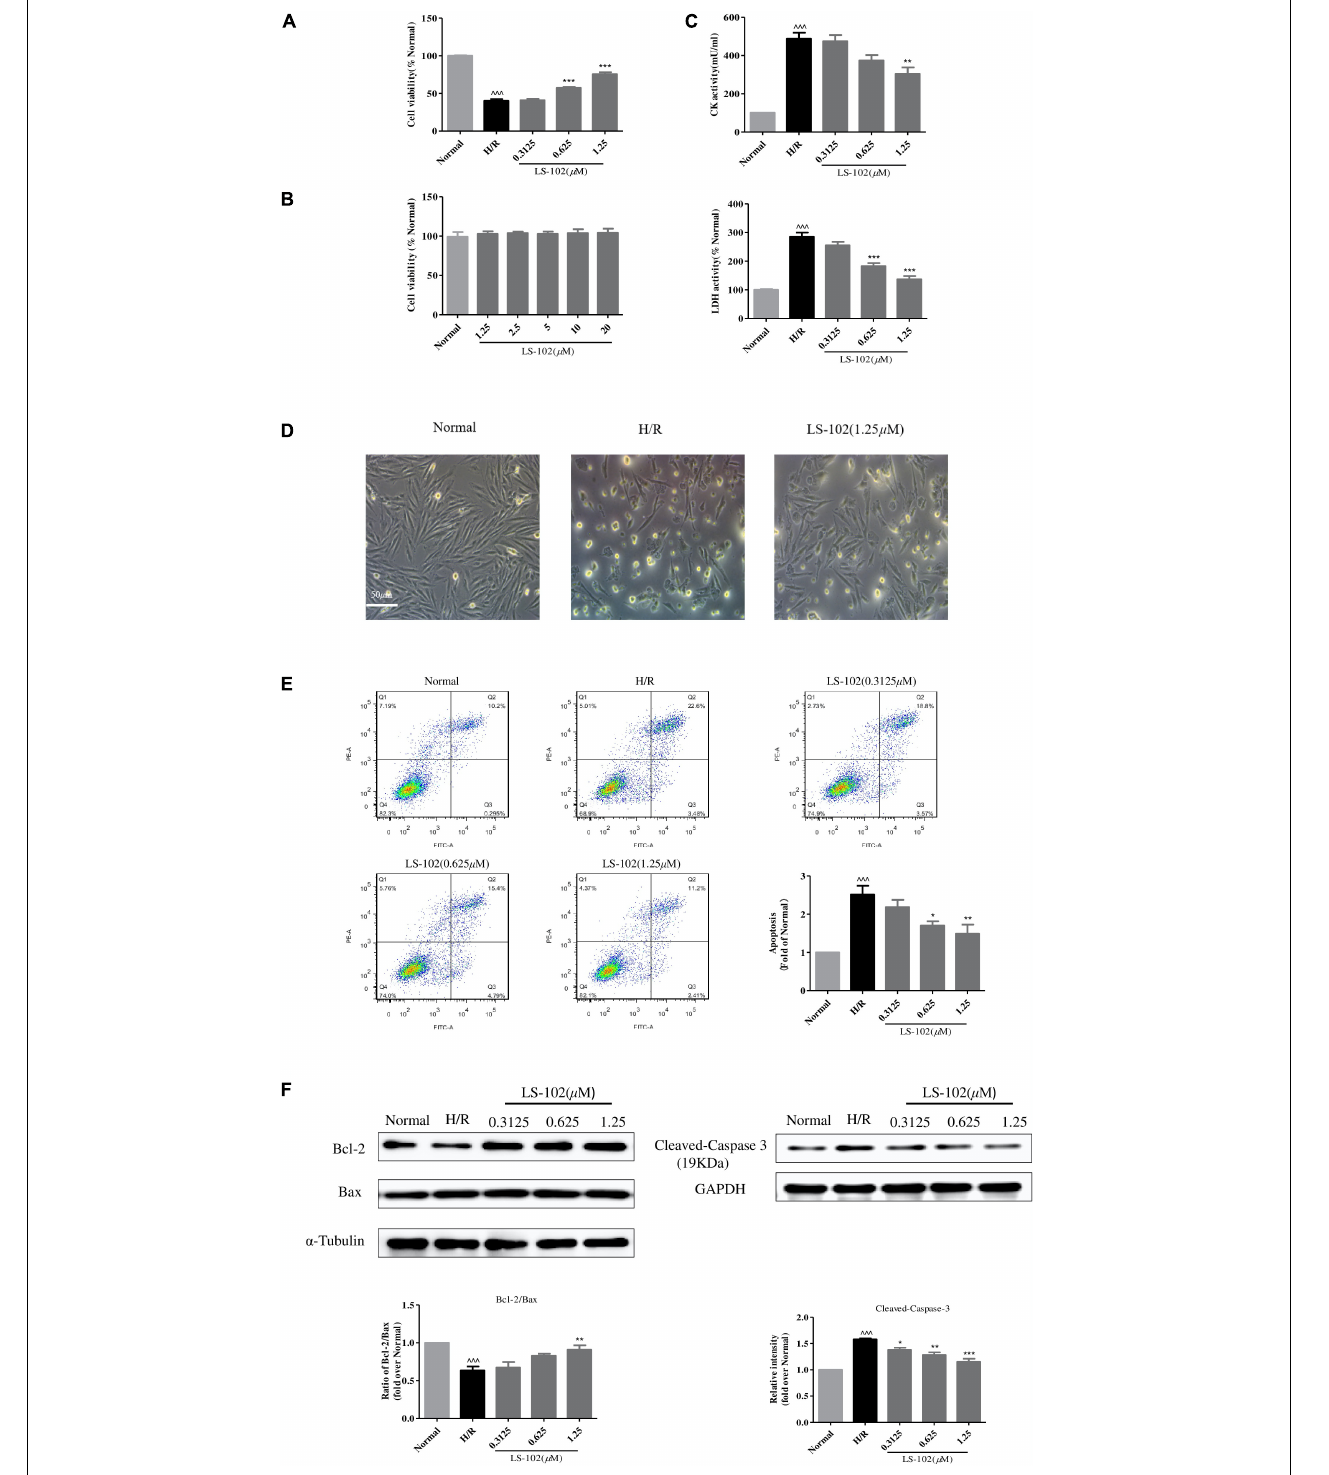
FIGURE 4 | Effects of LS-102 on cell survival after H/R in H9c2 cells. (A) Effect of LS-102 on cell viability. (B) Cytotoxicity of LS-102 in H9c2 cells under normoxia condition. (C) Effects of LS-102 on CK and LDH activities in serum. (D) Representative DIC images of H9c2 cells. (E) Effect of LS-102 on H/R-induced H9c2 cell apoptosis. Flow cytometry was used to detect apoptotic cells which were calculated the sum of the Q2 and Q3 quadrant. (F) Using western blot analysis to determine the protein expression of Bcl-2, Bax, and Cleaved-Caspase-3. The ratio of Bcl-2 to Bax was calculated and normalized to the Normal group. Values are means ± SEM of three or four independent experiments. ˆˆˆ P < 0.001 vs. Normal group. * P < 0.05, ** P < 0.01 and *** P < 0.001 vs. H/R group.